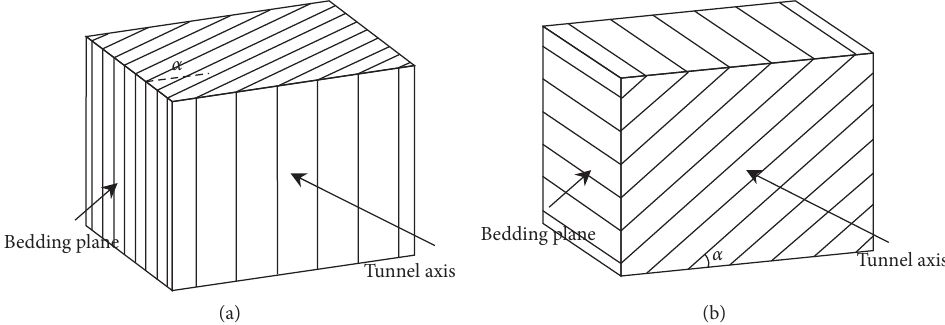
Figure 1: Sketch of the bedding plane and tunnel axis (indentation direction).